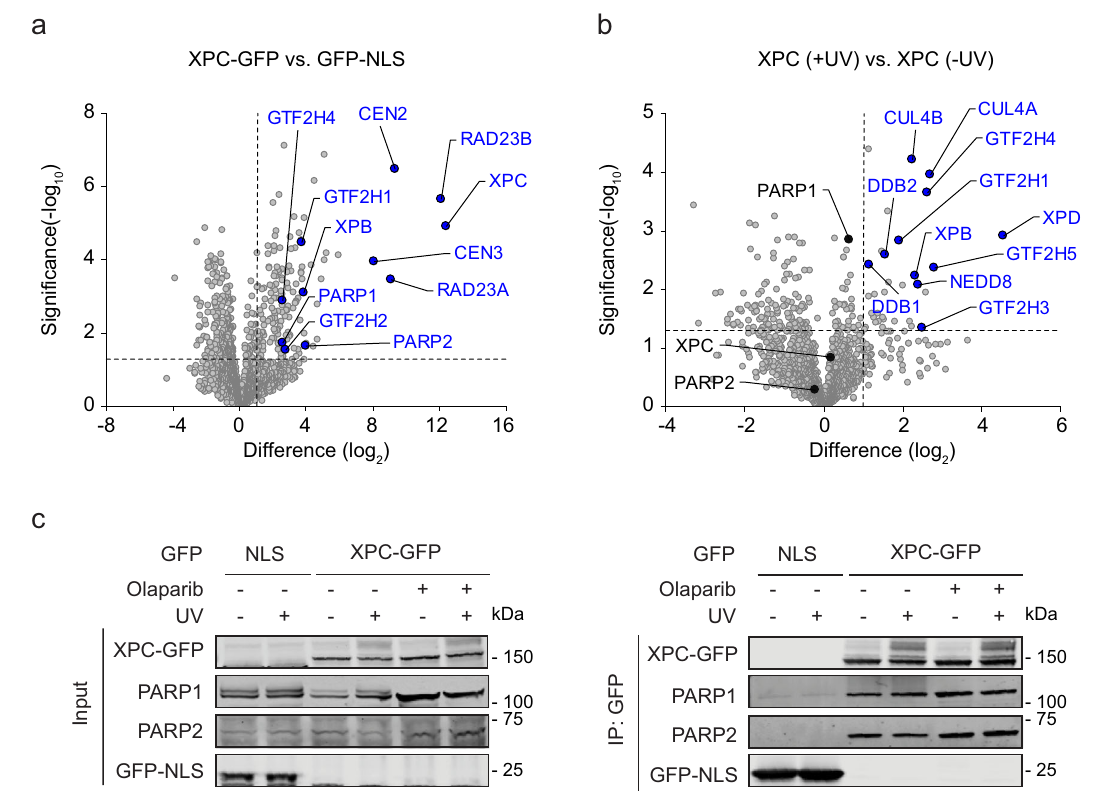
Fig. 1 XPC interacts with PARP1 and PARP2 in a UV-independent manner. a Volcano plot displaying the interactome of XPC-GFP over GFP-NLS after GFP-pull-down from U2OS (FRT) XPC-KO cells and analysis by label-free proteomics. b Differential interactome of XPC-GFP comparing UV-C-irradiated (20 J/m 2 , 1 h) vs. unirradiated U2OS (FRT) XPC-KO cells. a , b The dashed lines indicate a twofold enrichment on the x axis (log 2 of 1) and a signi fi cance of 0.05 ( − log 10 P value of 1.3; two-sided t test) on the y axis. c Co-Immunoprecipitation (Co-IP) of GFP-NLS and XPC-GFP in the presence and absence of UV- C (20 J/m 2 , 1 h) and the PARP inhibitor olaparib (10 µ M). Three independent replicates of each IP experiment were performed obtaining similar